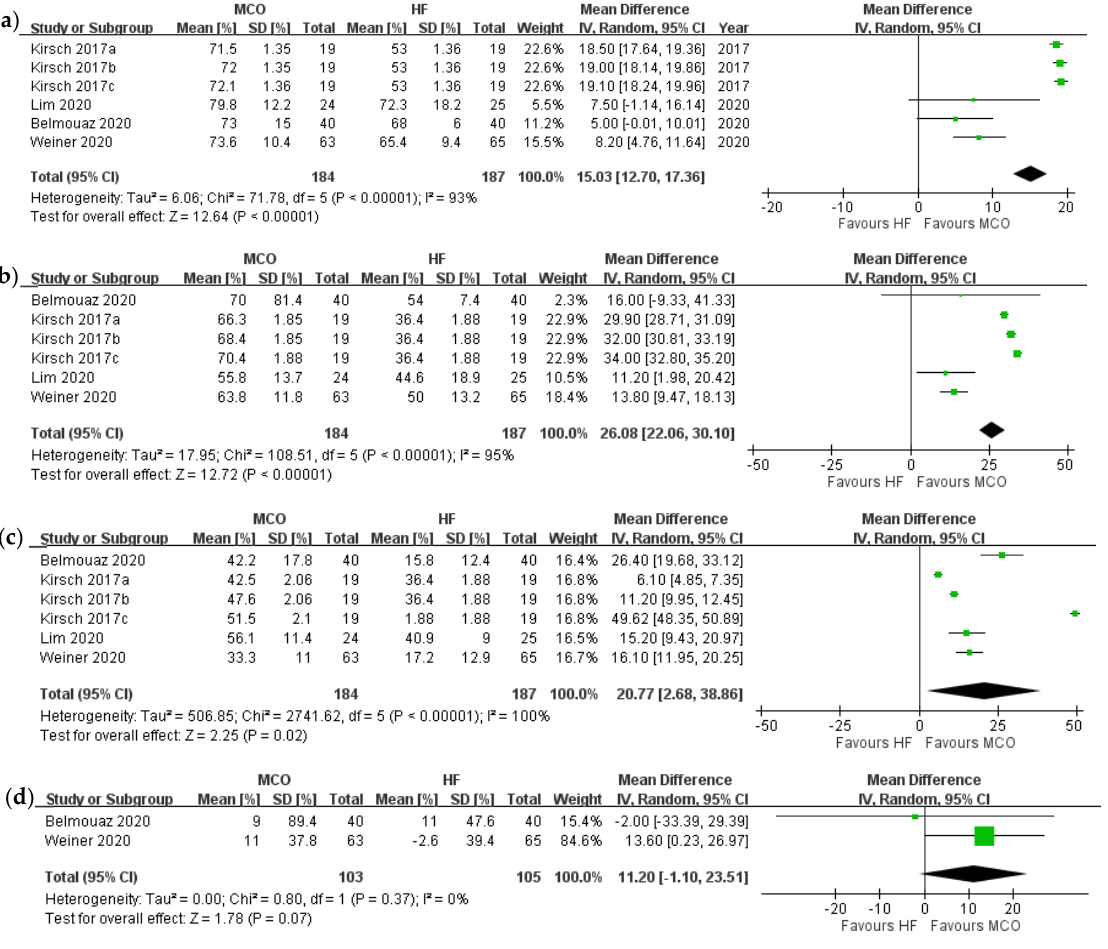
Table 2. Reduction ratio of beta 2-mircoglobulin